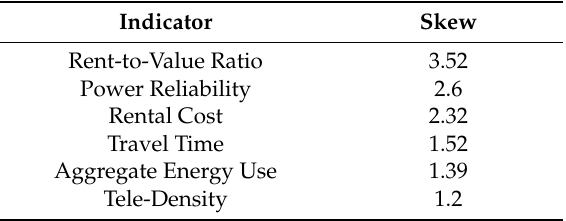
Table 7. Indicators with the Largest Positive